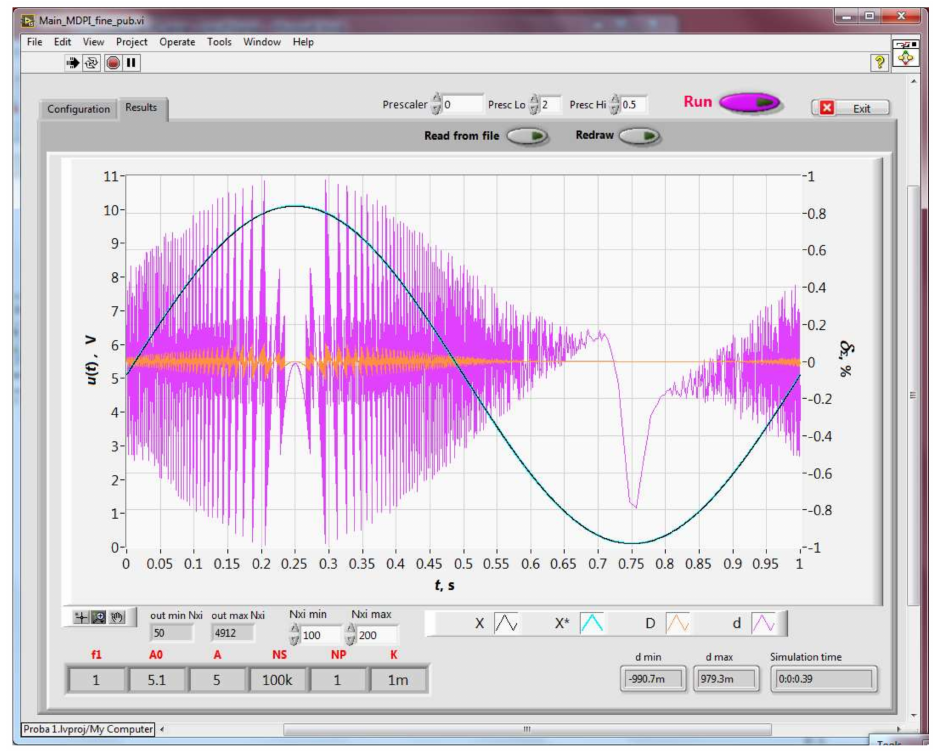
Figure 12. The panel of the simulator program presenting the initial simulation results of an exem- plary test